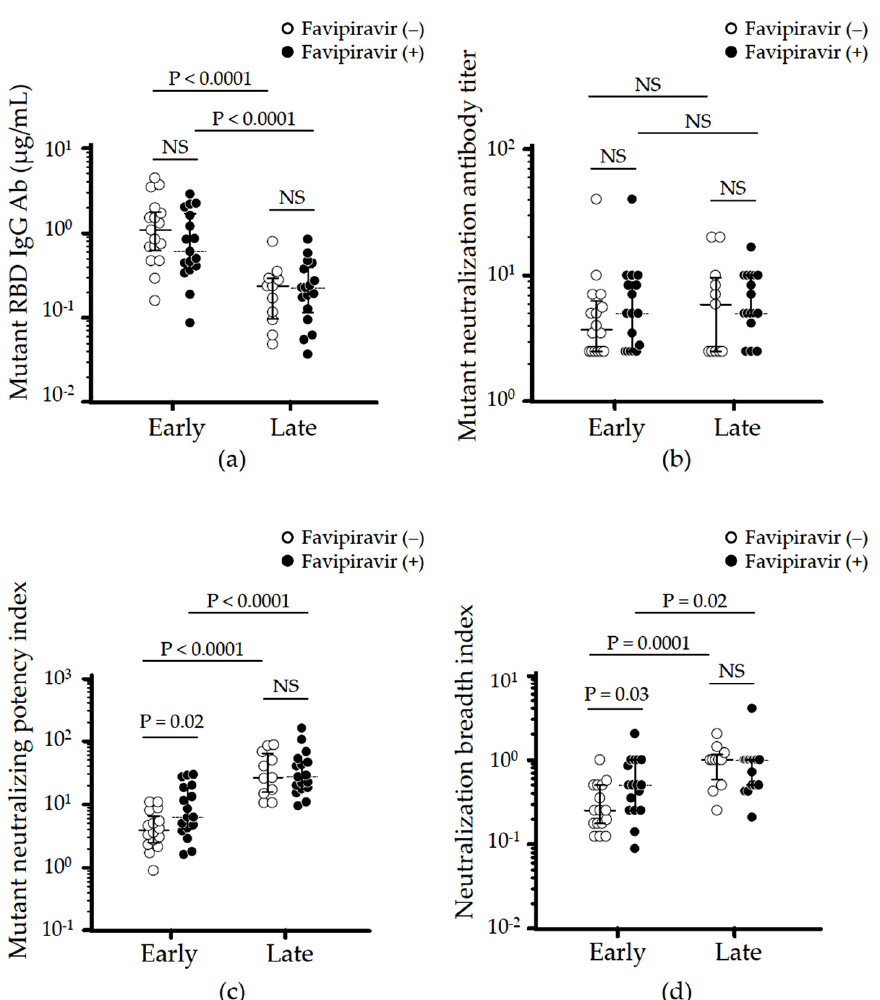
Figure 4. Effect of favipiravir on cross-reactive humoral immunity against SARS-CoV-2 variants carrying K417N, E484K, and N501Y in moderate COVID-19 patients infected with WT SARS-CoV-2. The highest values of ( a ) mutant-RBD IgG antibody production, ( b ) mutant-neutralizing antibody titer, ( c ) mutant-neutralizing potency index, and ( d ) neutralizing breadth index indicating the cross- neutralizing capacity in early (<180 days after symptom onset) versus late (>180 days after symptom onset) convalescent serum from each recovered patient were analyzed and compared. Statistical analyses were done using the Wilcoxon test or paired t -test as appropriate for early vs. late in the same treatment group and Mann–Whitney U-test or t -test as appropriate for case ( • ) vs. control ( ◦ ) in the same time phase. NS: not